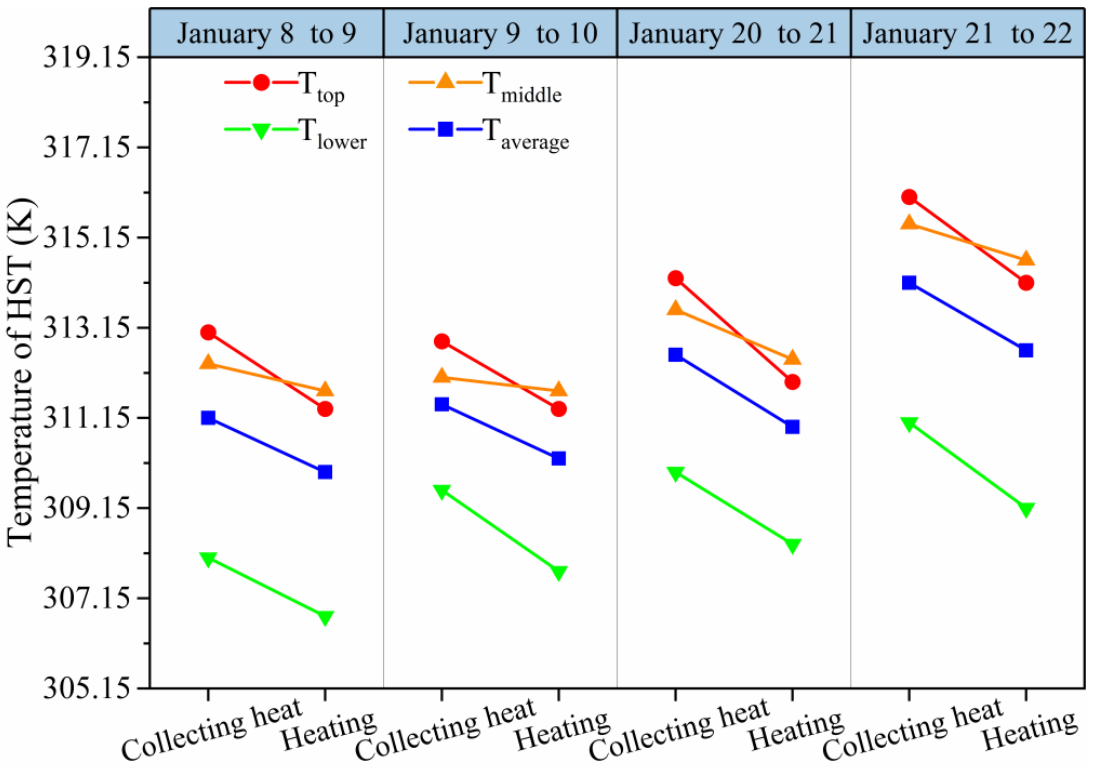
Figure 7. Comparison of HST temperatures immediately after heat accumulation and at the time of heating.